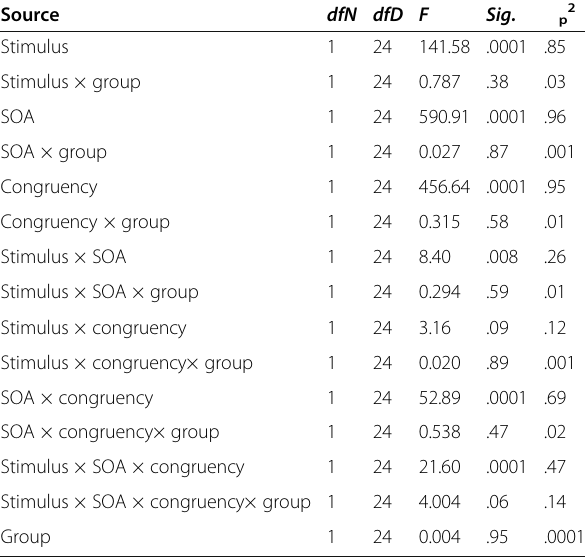
Table 3 The results of independent t tests between sham and experimental